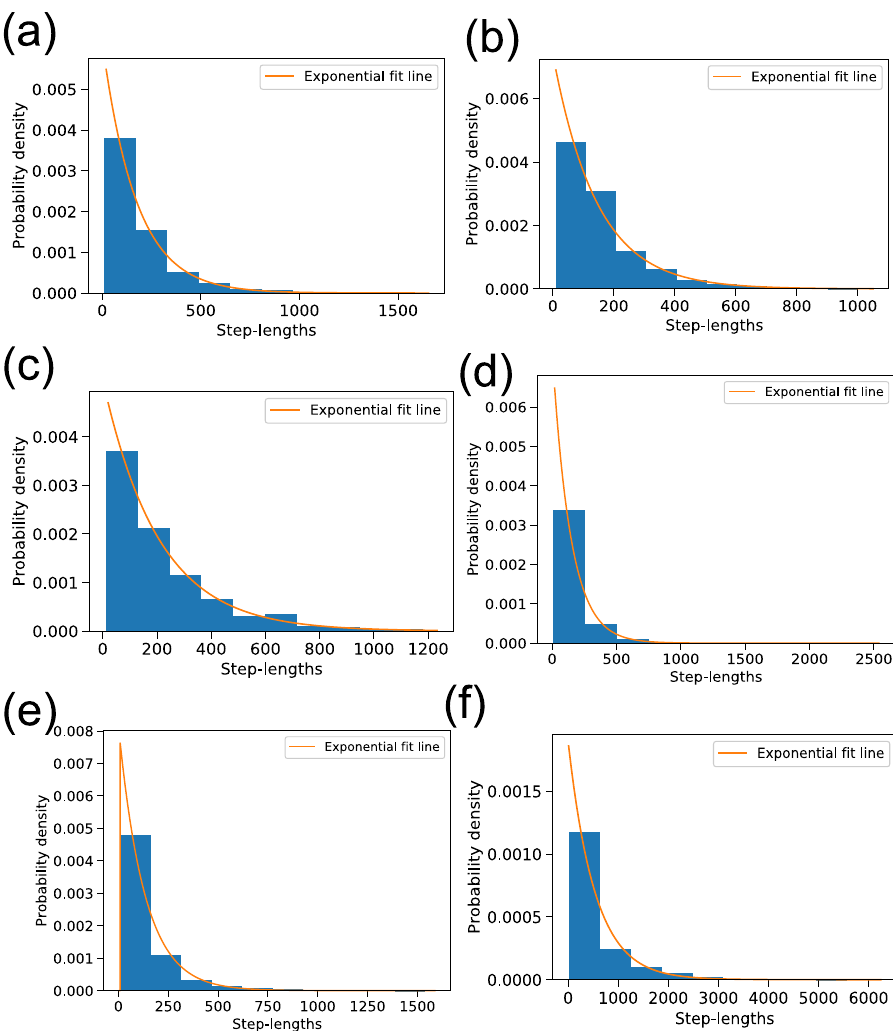
Figure 9. Best fit lines corresponding to exponential distribution of step lengths for different hornbills. ( p -values from KS test for ( a ) GH1Br ( p 0.0028 ), ( e ) GH5NBr ( p GH2NBr ( p =